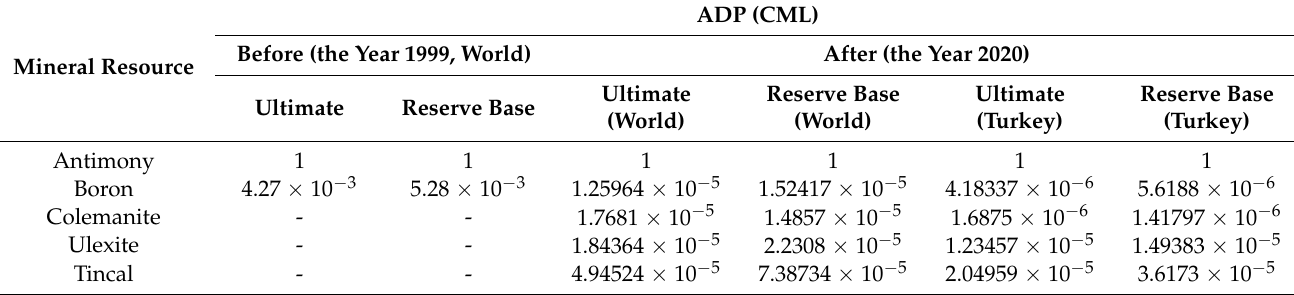
Table 7. Characterization factor that was obtained by CML method (the year